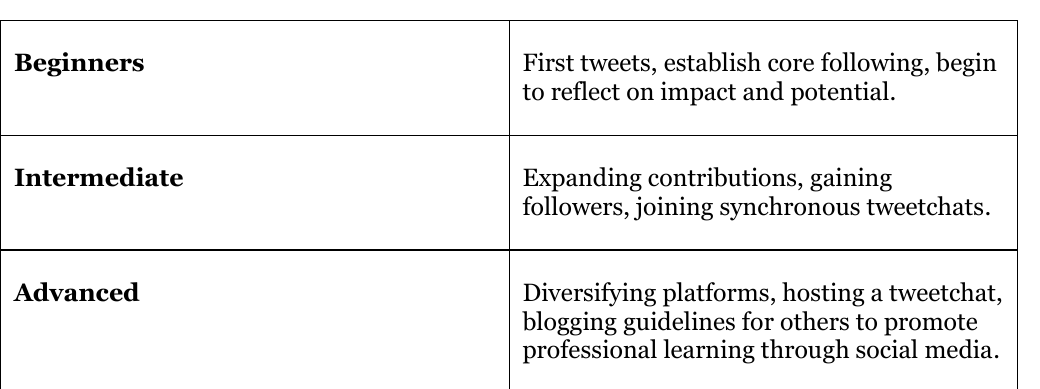
Structuring Challenges to Suit Level of Expertise Level of